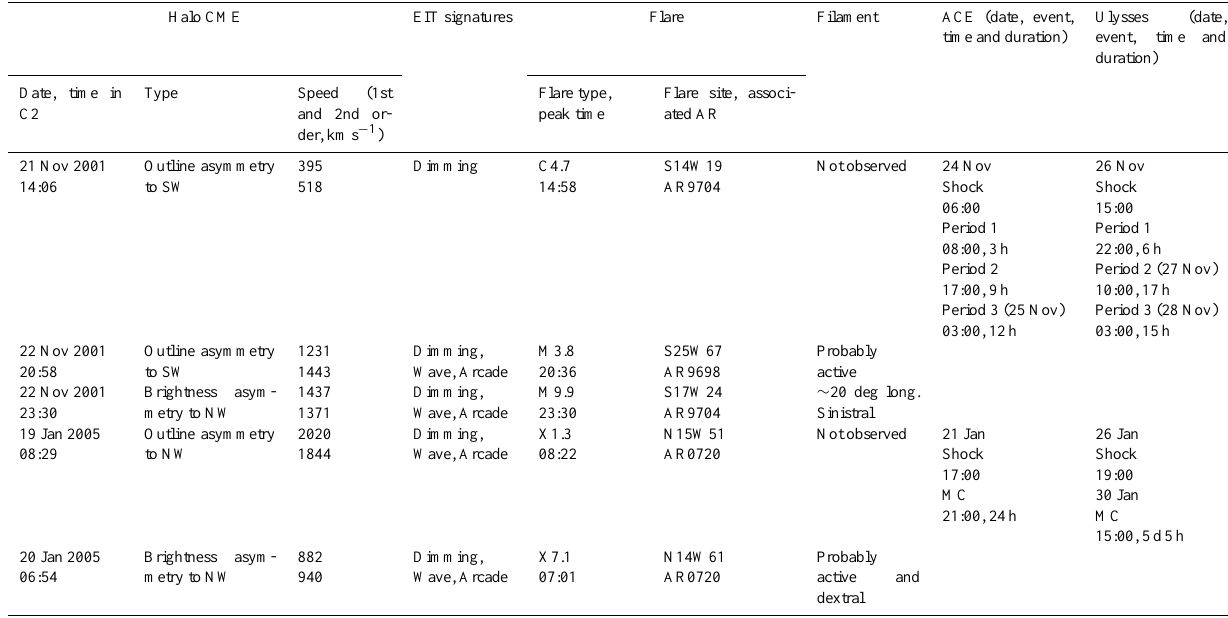
Table 1. Characteristics and timings of the candidate halo CMEs, their associated solar signatures and interplanetary counterparts. Halo CME EIT signatures Flare Filament ACE (date, event,